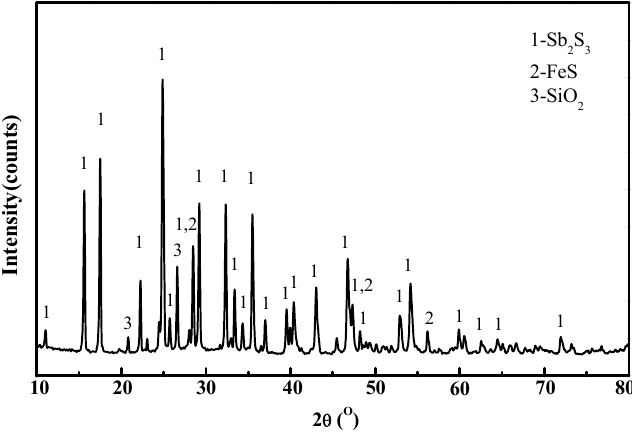
Figure 2. Phase composition of the stibnite concentrate.